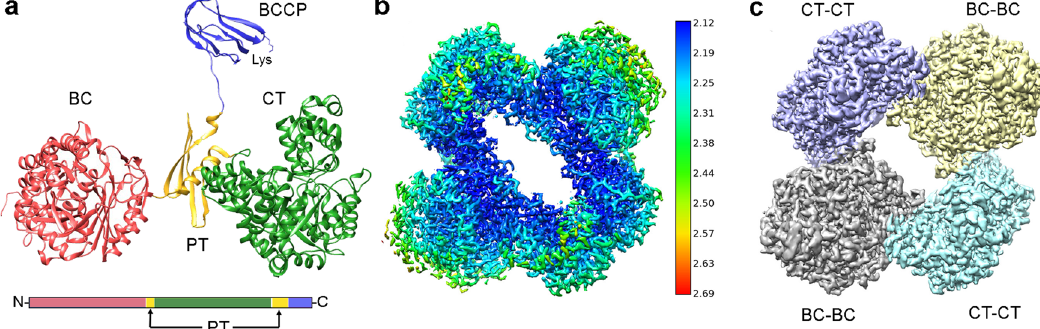
Fig. 1 | Structure of LlPC. a Atomic structure of LlPC (pdb code 5vyz 30 ) subunit colored by different domains, together with the distribution of these domains in the primary structure of the protein. The lysine at the BCCP domain is the residue where prosthetic biotin is attached. b CryoEM map for LlPC in the presence of acetyl-CoA, substrates and co-factors. The 3D map is colored by estimates of local